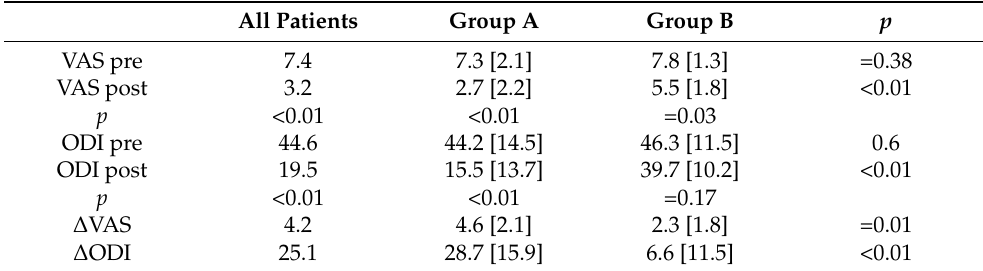
Table 2. Pre- and postoperative clinical findings; mean [standard deviation].